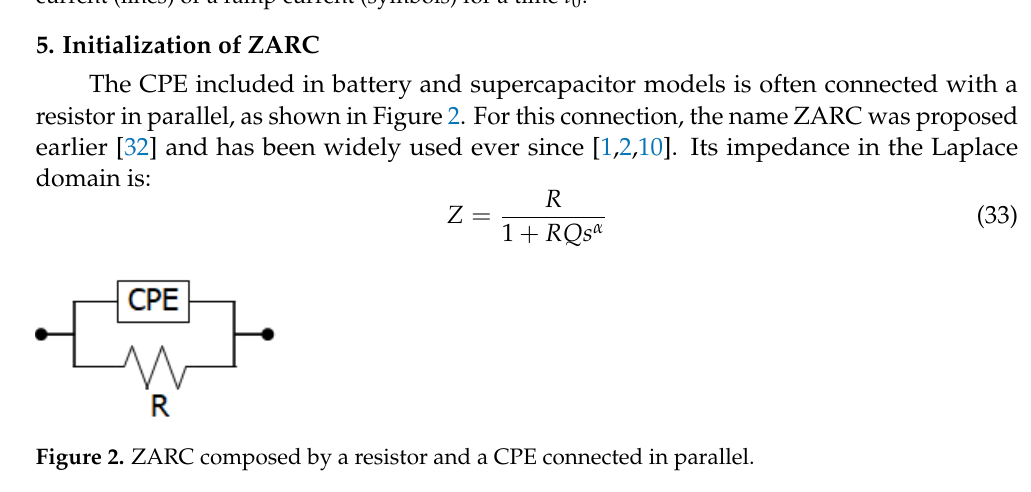
Figure 1. Decay functions of the initial voltage obtained for a CPE with α = 0.5 by applying a constant current (lines) or a ramp current (symbols) for a time t 0 .